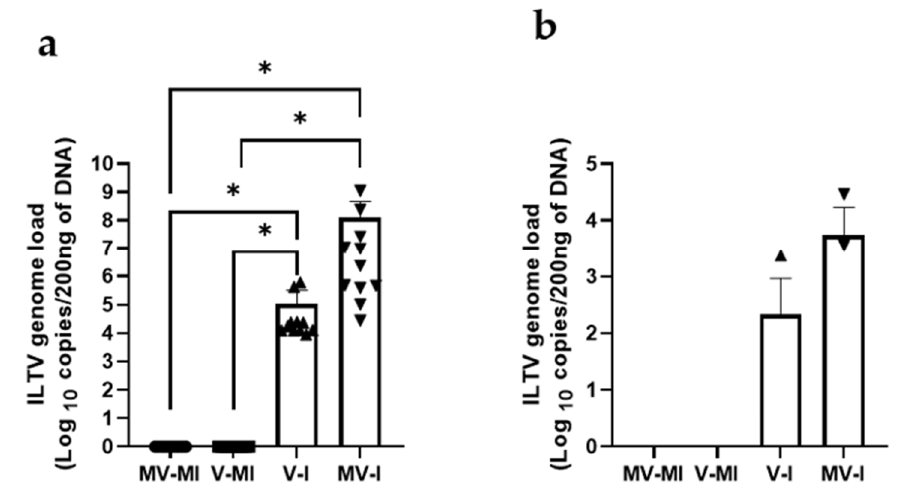
Figure 6. ILTV genome loads in trachea ( a ) and lungs ( b ) at 14 dpi. The quantification of ILTV genome loads was performed targeting the ILTV PK gene using qPCR assay. Mean genome load is plotted in log 10 scale and represented in bars with standard error of means (SEM). Kruskal–Wallis test followed by Dunn’s multiple comparison test was performed to identify group differences. * = p < 0.05.